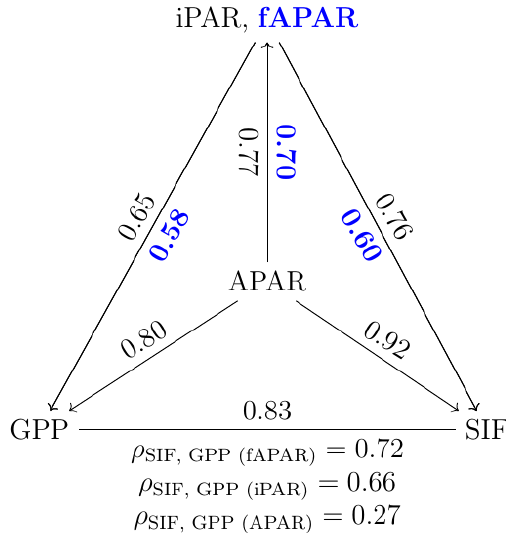
Figure 2. Pearson correlation coefficients among the canopy vari- ables iPAR canopy , APAR canopy , fAPAR canopy (indicated in bold blue text), GPP and SIF for a corn canopy across the 2017 grow- ing season, based on the data set shown in Fig. 1a and b. The partial correlation coefficients between SIF and GPP (listed at the base of the triangle) were determined by removing the effects of the con- trolling variables, fAPAR, iPAR and APAR, respectively. Measure- ments had a 30min